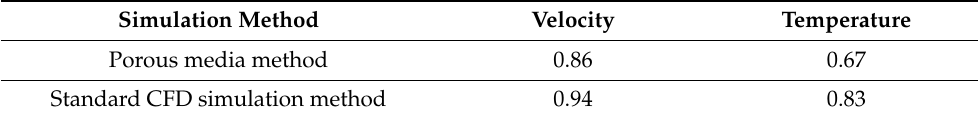
Table 4. Coefficient of